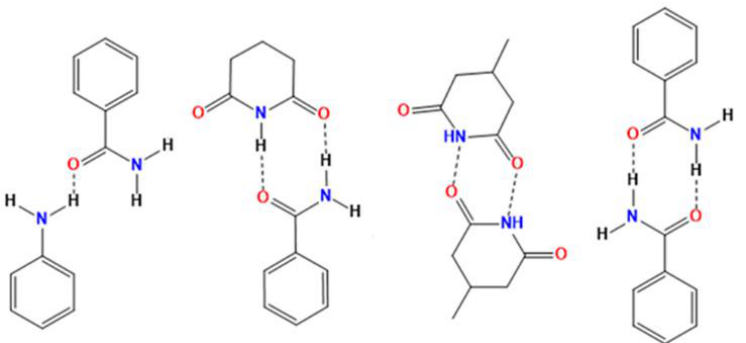
Figure 1. Examples of some probable supramolecular synthons that may be present in AMG-eutectic systems.